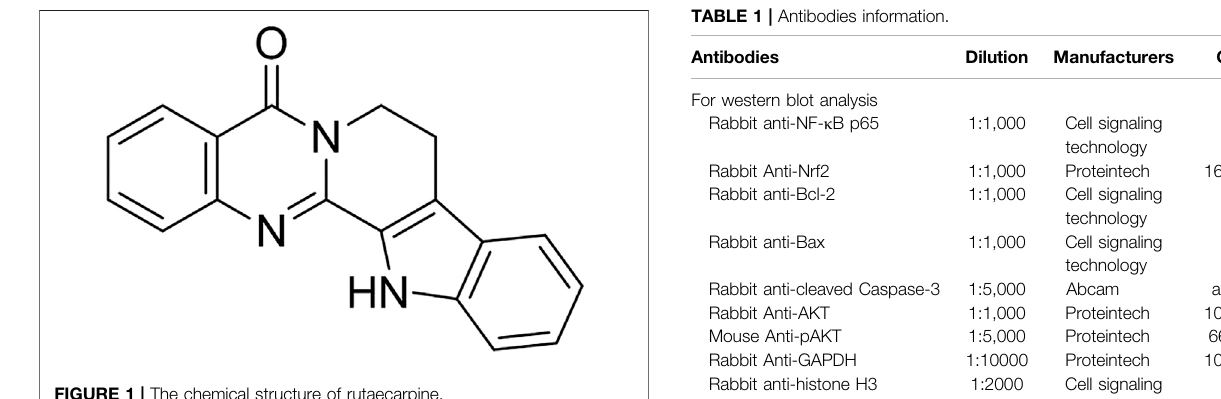
FIGURE 1 | The chemical structure of